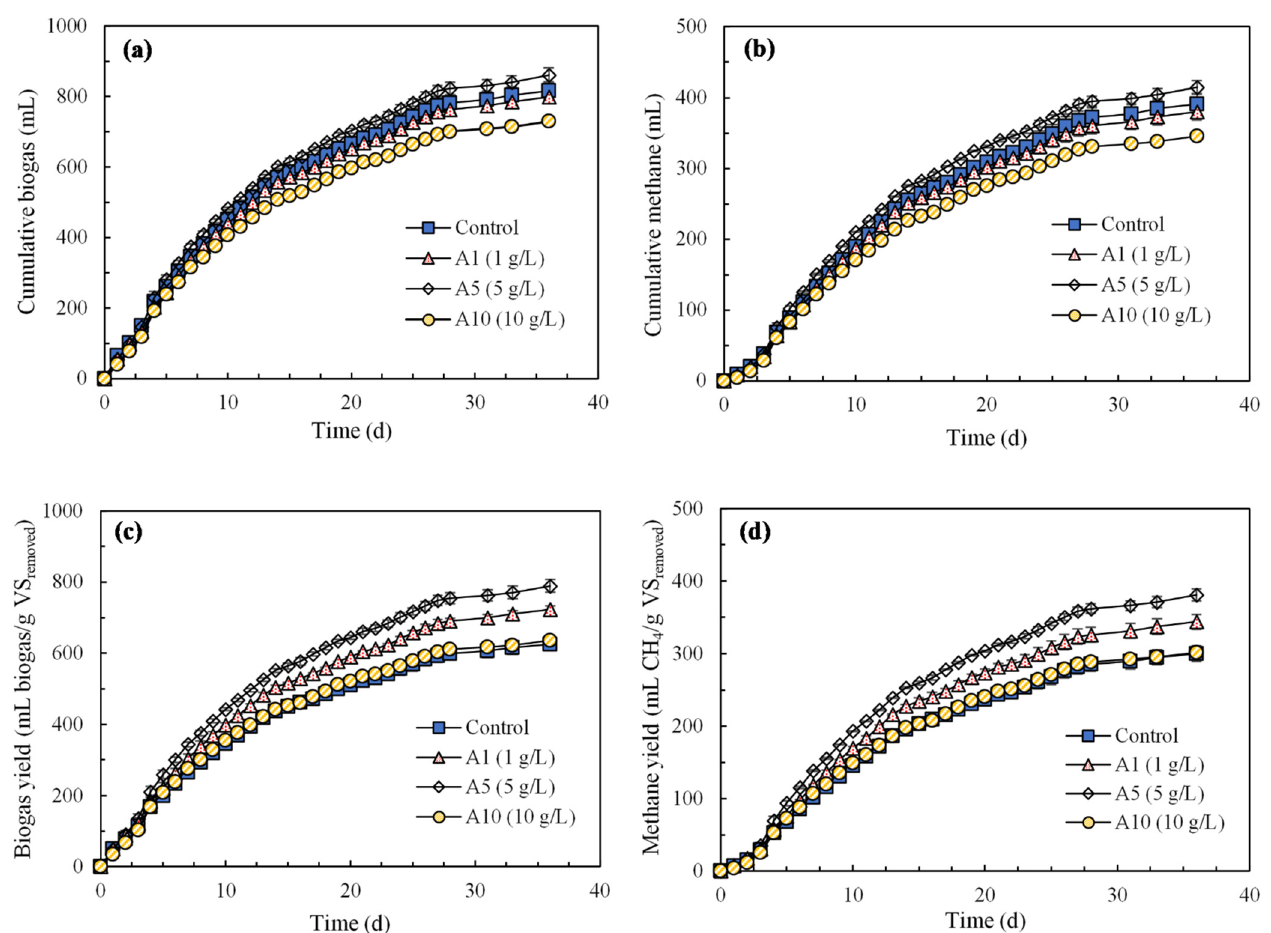
Figure 1. Cumulative biogas and methane volume ( a , b ) and yield ( c , d ) from AD of dairy manure with the addition of different concentrations of AF-BC.